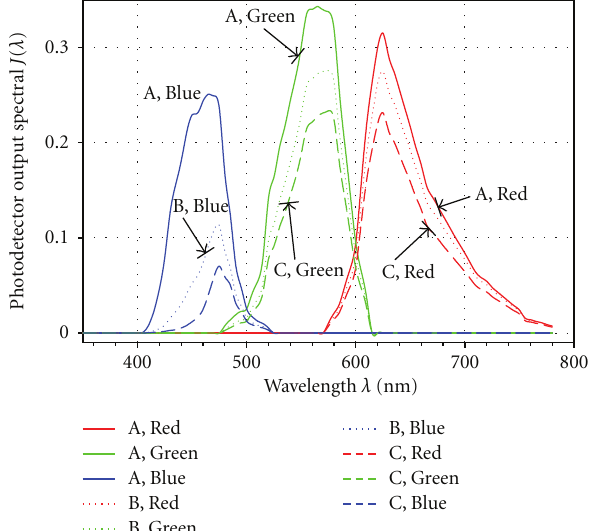
Figure 5: Photodetector output spectra in DTE24 #1 calibration oil.